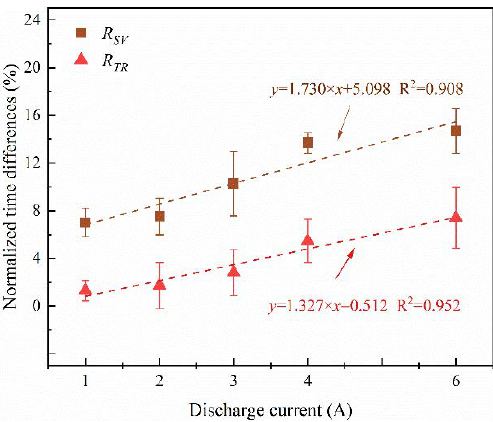
Figure 9. Normalized time reductions in safety venting and thermal runaway under different discharge currents in Group iii.